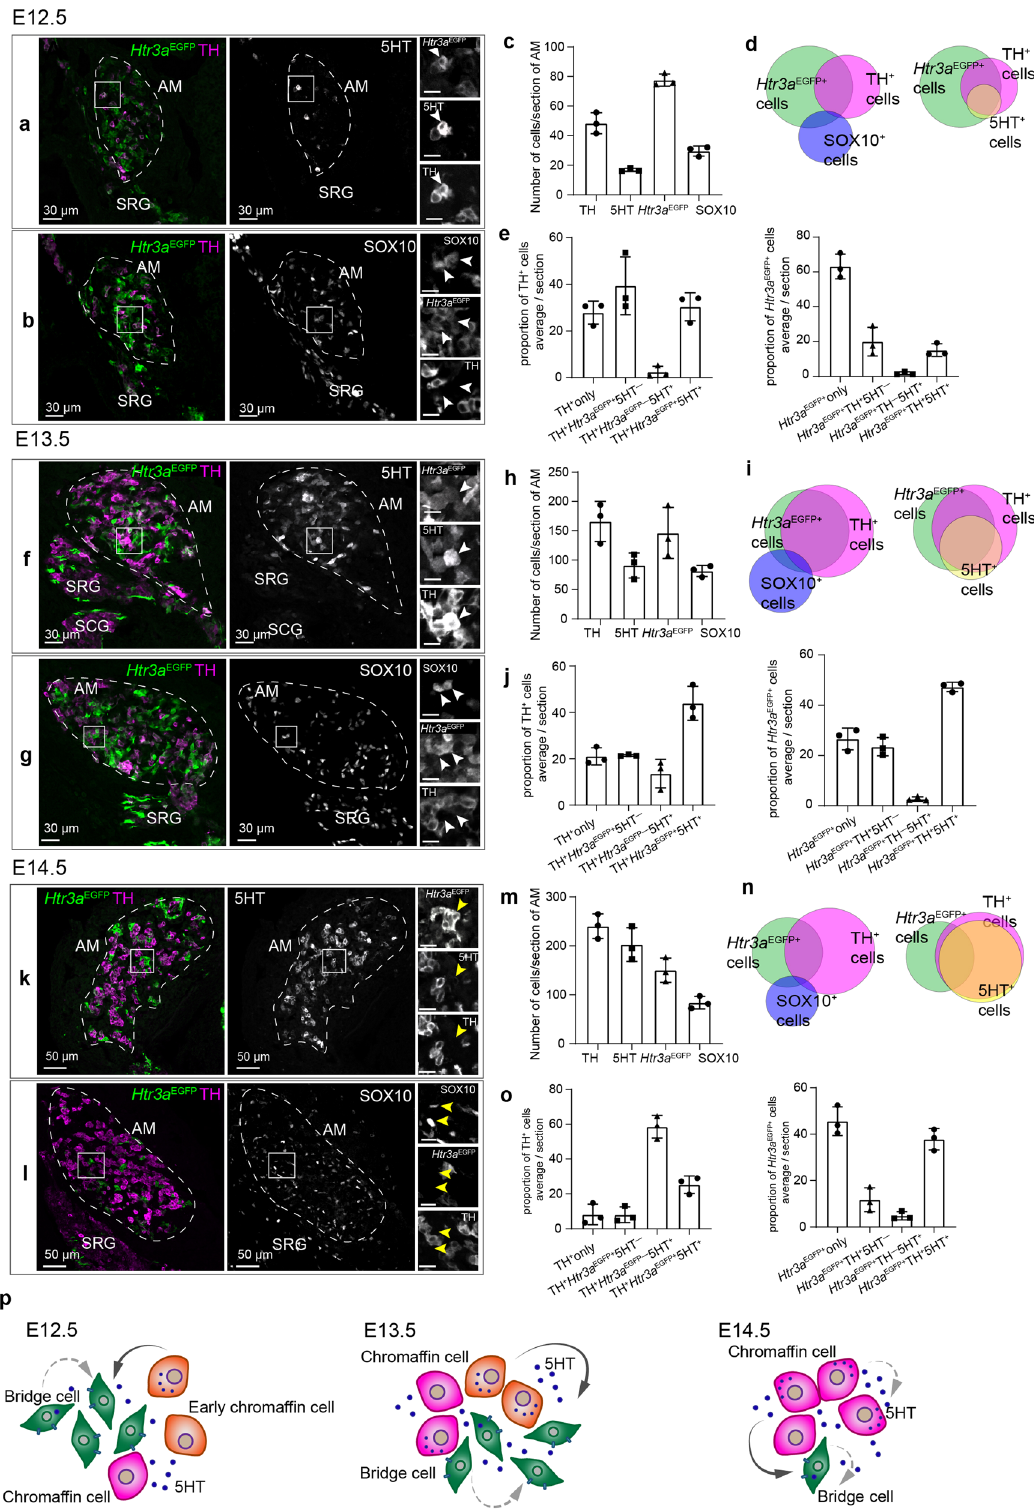
To make sure that the effect of 5HT on the AM size is consistent in a different rodent model, we analyzed the adrenal glands of mice and obtained consistent results (Fig. 2h). 5HTP treatment of pregnant rats and mice during the active differentiation of “ bridge ” cells into chromaf fi n cells resulted in a long-lasting reduction of AM size in embryonic and postnatal life in both species. Administration of 5HTP outside this critical